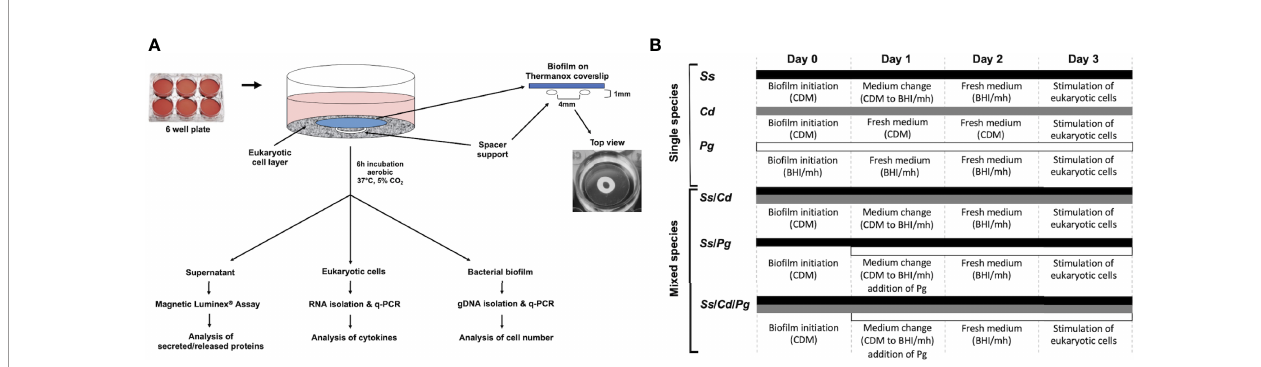
FIGURE 1 | Experimental set-up for bacterial bio fi lm formation and its interaction with oral mucosal and gingival cells. (A) Oral epithelial cells were grown in 6-well plates and challenged with bacterial bio fi lms that were separately grown on Thermanox coverslips. Mature bio fi lms were developed and incubated with medium changes every 24 h for 72 h. The coverslips were carefully placed with the bio fi lm facing toward the epithelial cells on a spacer which forms a gap of approximately 1 mm. Subsequently, the cells were incubated for 6 h. To determine the expression of IL-6 and IL-8 with q-PCR as well as the abundance of selected immune markers with Magnetic Luminex ® Assay, the supernatants and the eukaryotic cells were collected and processed as described in the Materials and Methods. Bio fi lm cells were collected to determine the number and composition of the bio fi lms with q-PCR. (B) Thermanox cover slips were inoculated with bacteria from single species pre-cultures as described in Material and Methods at d 0. After 24 h (d 1), the growth medium was changed. For bio fi lms containing P. gingivalis , the species was added as indicated on day 1. After 48 h (d 2), the medium was changed, and at 72 h (d 3), bio fi lms were used for stimulating the eukaryotic cells. Different bars indicate the presence of respective species at the corresponding time points. CDM, chemical de fi ned medium; BHI/mh, brain heart infusion supplemented with menadione (5µg/ml) and hemin (1µg/ml); Ss , S. sanguinis SK36, Cd , C durum JJ1, Pg , P. gingivalis